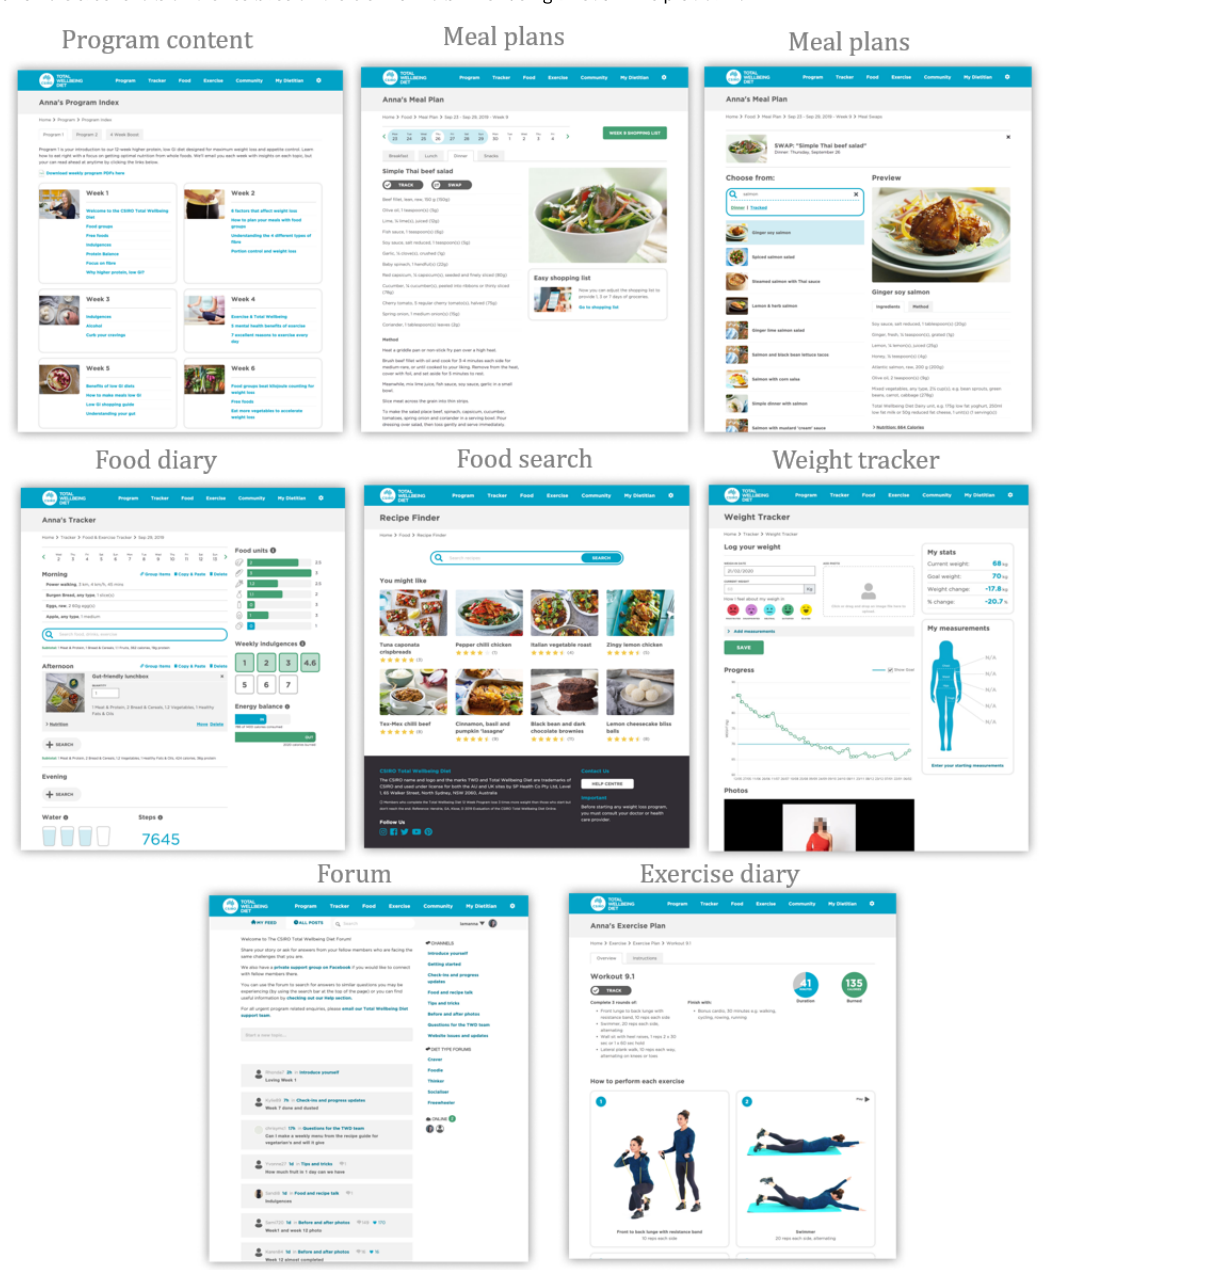
Figure 1. Screenshots of the features of the CSIRO Total Wellbeing Diet Online